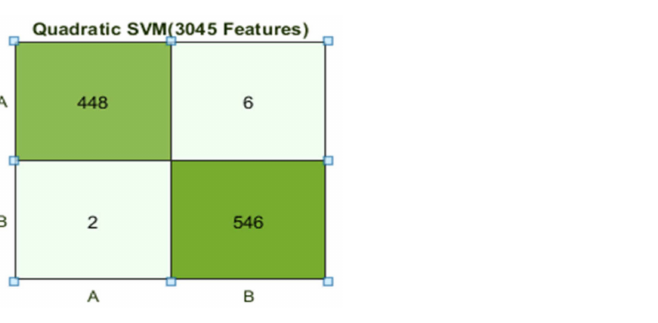
Figure 10. Confusion matrix for Q(SVM) with 3045 features and using 10-fold results.